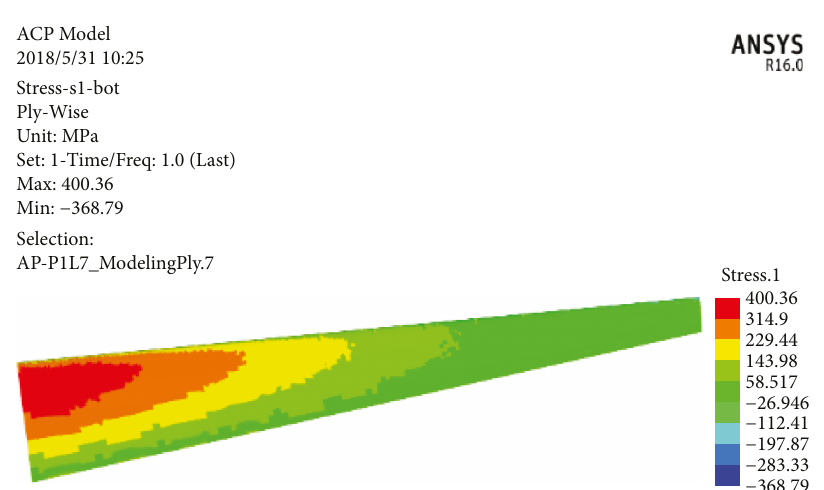
Figure 16: Stress cloud diagram of the lower wing with the layer sequence being [0/45/90/-45/0]